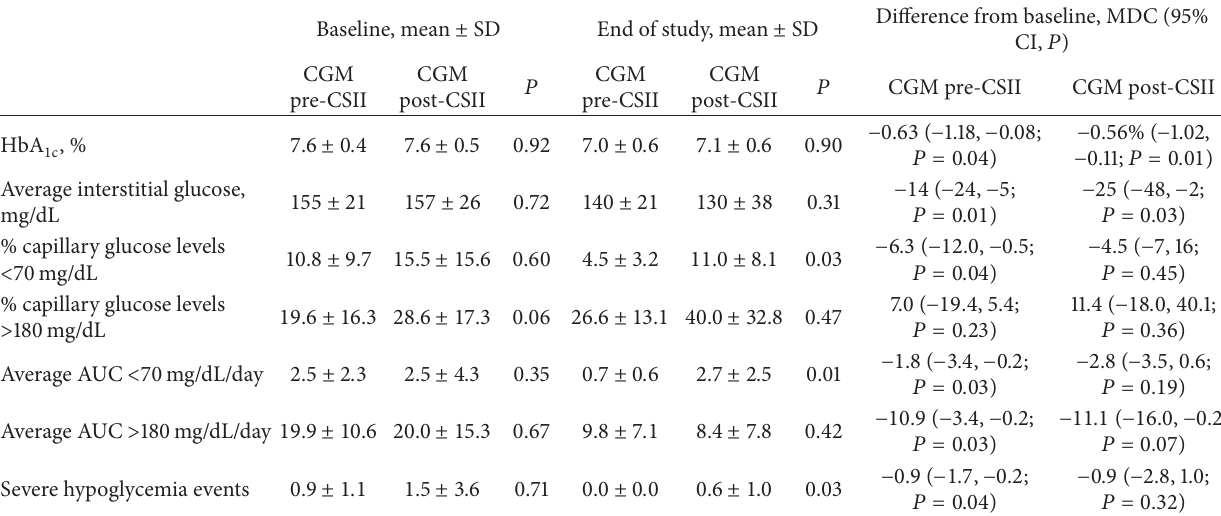
Table 2: Glycemic